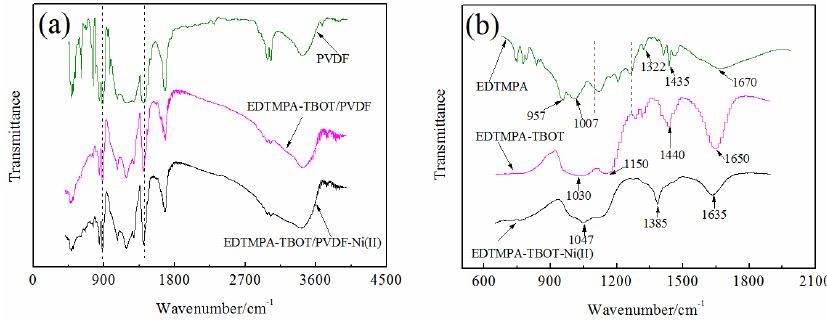
Figure 2. FTIR spectra: ( a ) the virgin PVDF membrane and the EDTMPA-TBOT/PVDF chelating membrane before and after Ni(II) adsorption; ( b ) the virgin EDTMPA and the EDTMPA-TBOT powder before and after Ni(II) adsorption.